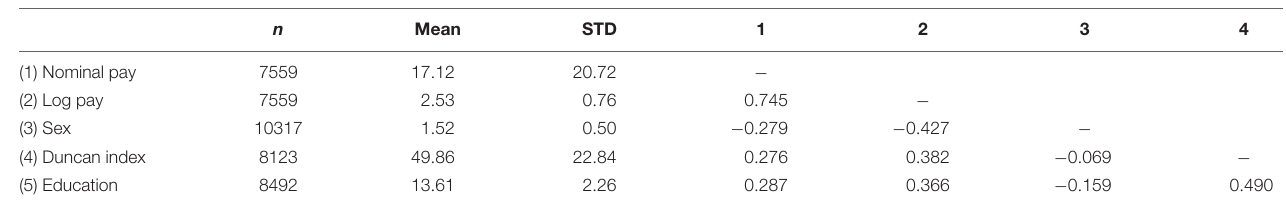
TABLE 1 | Descriptive statistics and inter-correlations of the variables in Study 1.